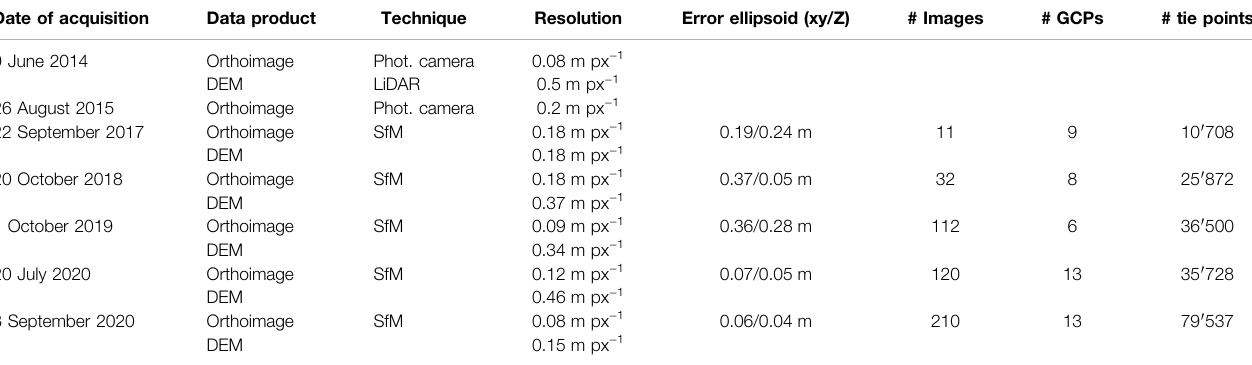
TABLE 1 | DEMs and orthoimages used in this